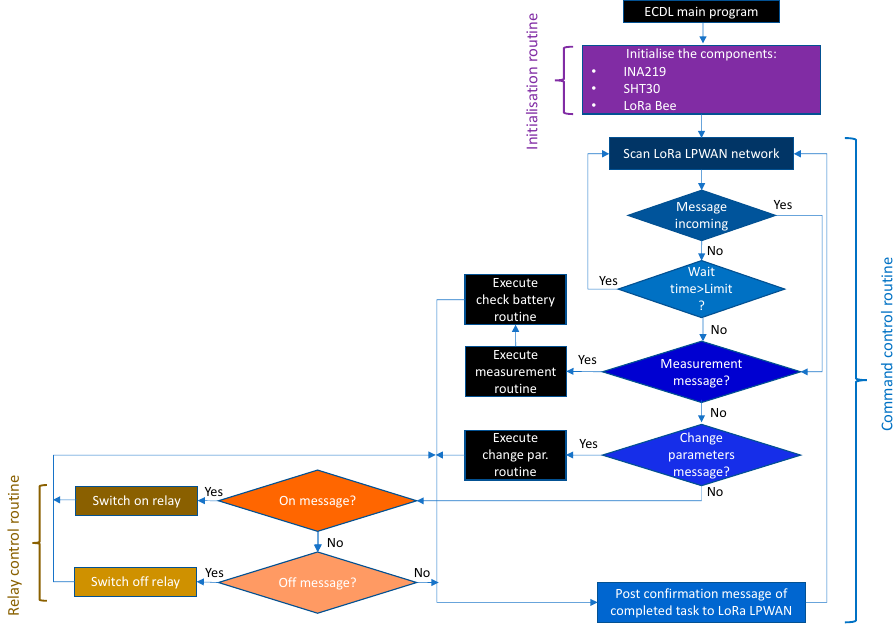
Figure 16. Flow chart of the main program for the ECDL.